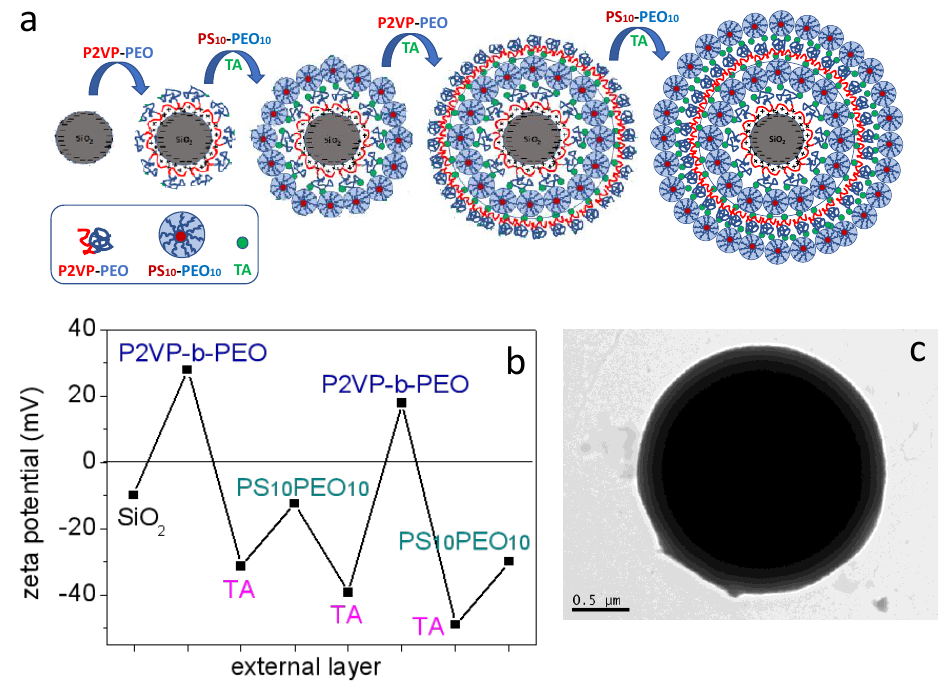
Figure 6. ( a ) Schematic representation of the LbL fabrication of SiO 2 @P2VP- b -PEO@TA@PS 10 - PEO 10 @TA@P2VP- b -PEO@TA@PS 10 -PEO 10 hybrid (the various building blocks, P2VP- b -PEO, PS 10 -PEO 10 stars, and TA (tannic acid), are also illustrated to the lower left). ( b ) Evolution of zeta potential during deposition of multilayer on surfaces of silica particles in aqueous solution. ( c ) TEM image of the hybrid microparticle.